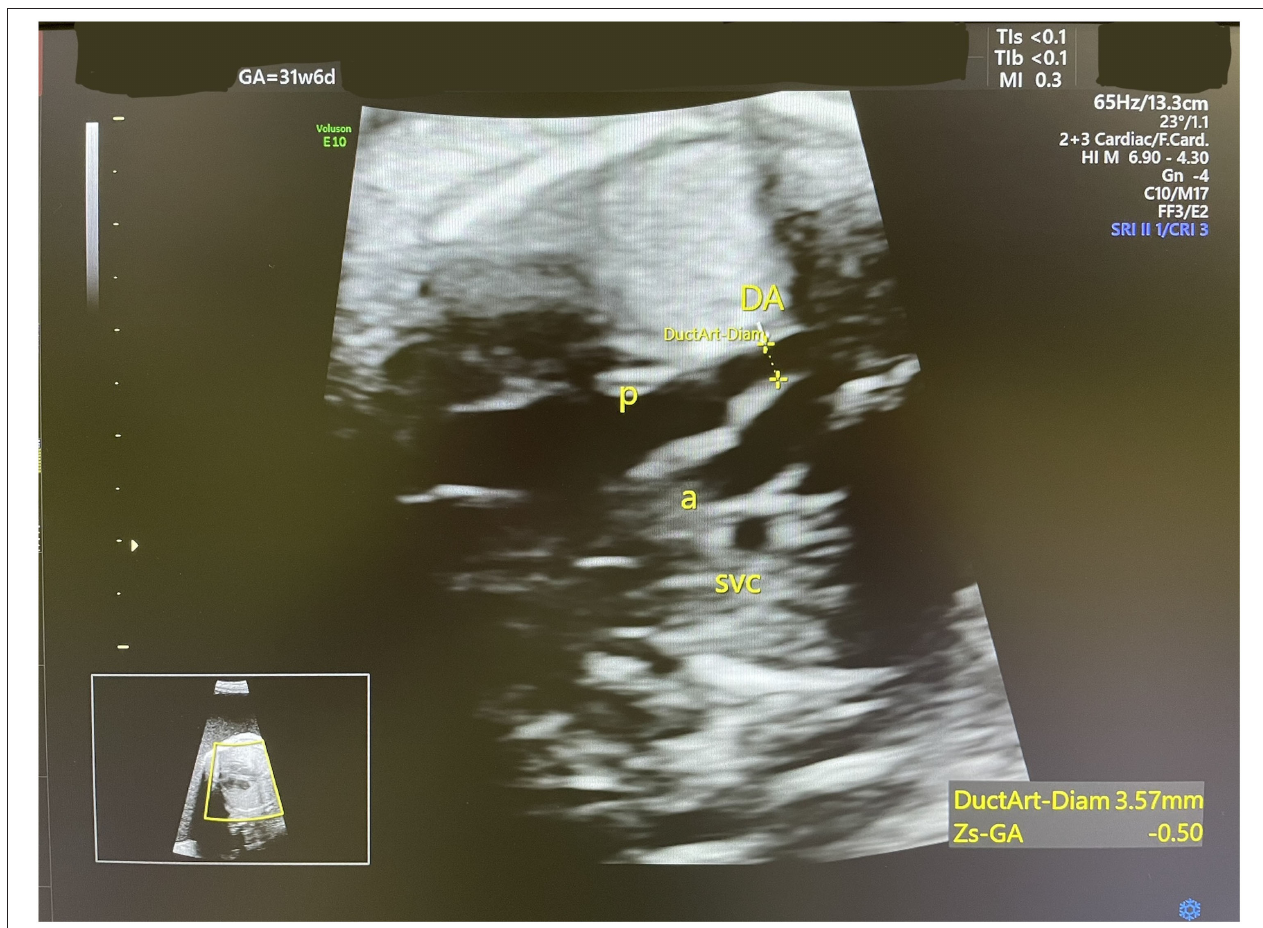
FIGURE 3 | An ultrasound scan shows DA diameter at 31 weeks 6 days (3.57mm, 6th